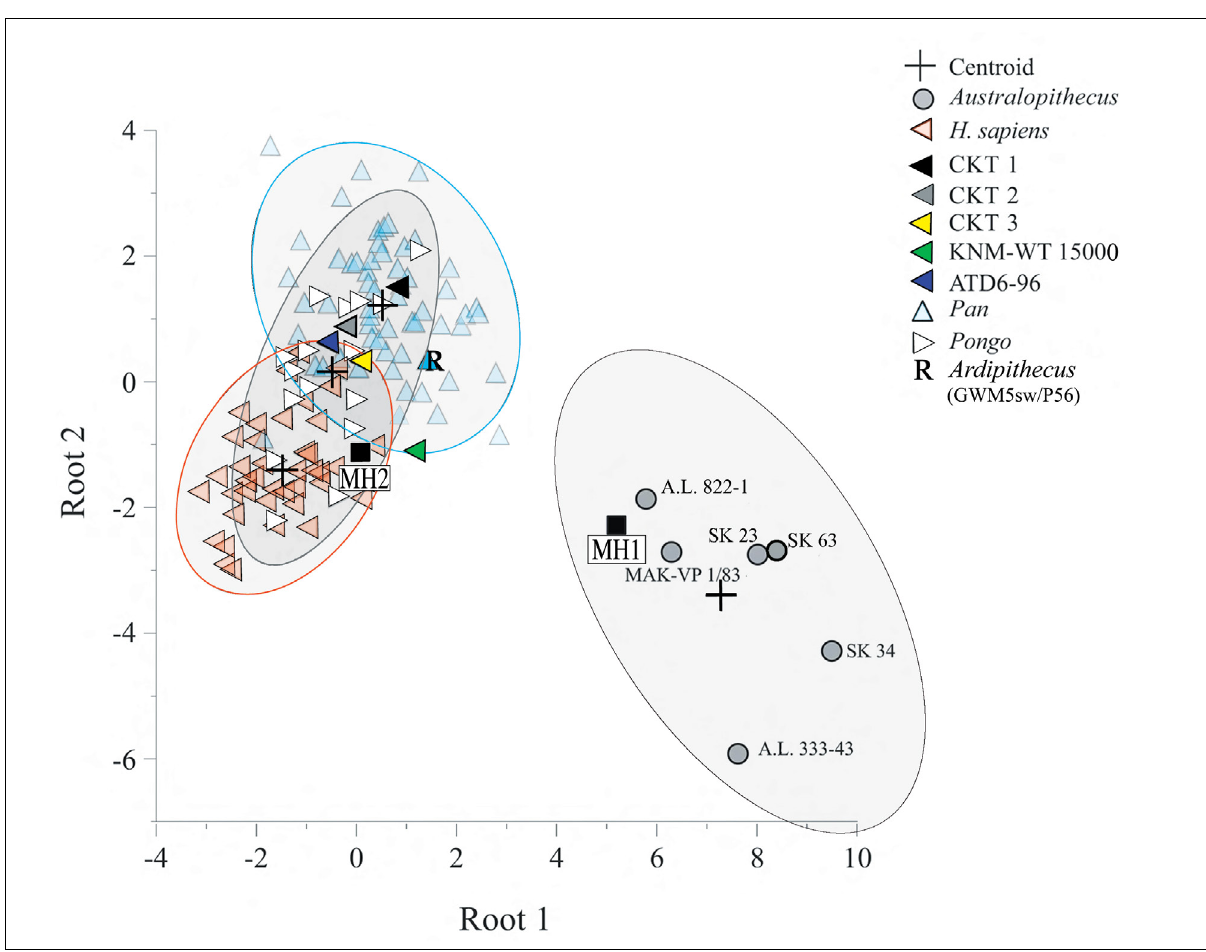
Figure 8: Discriminant function plot including CKT, Choukoutien; KNM-WT 15000, Homo ergaster ; ATD696, a mandible from Gran Dolina, Spain. Roots 1 and 2 account for 59% and 34% of the variation, respectively. MH1 falls within the Australopithecus cluster (with a probability of 0.98), as do the infants A.L. 33343 and SK 63. MH2 falls within the generalised ramus group (with a probability of 1.0), as does Ardipithecus ramidus (with a probability of 0.98). The ellipses represent a confidence level of